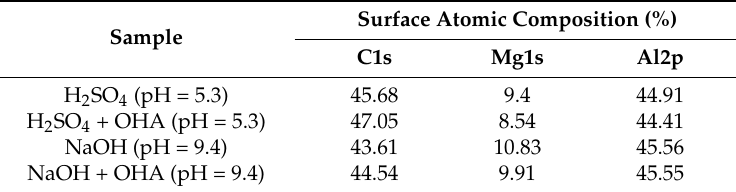
Table 7. Relative contents of elements on MA-spinel